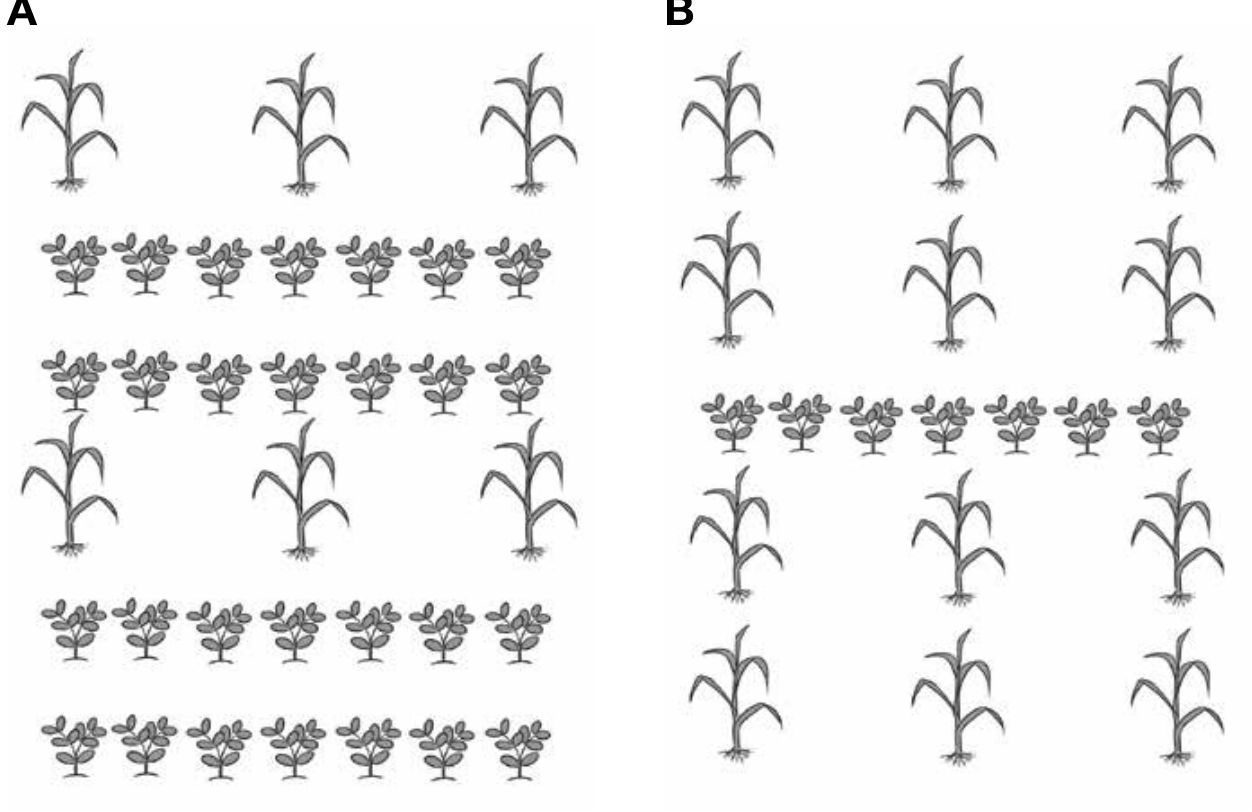
Figure 2: Planting arrangements for groundnut-sorghum intercrop. A: prioritising groundnut. B: prioritising